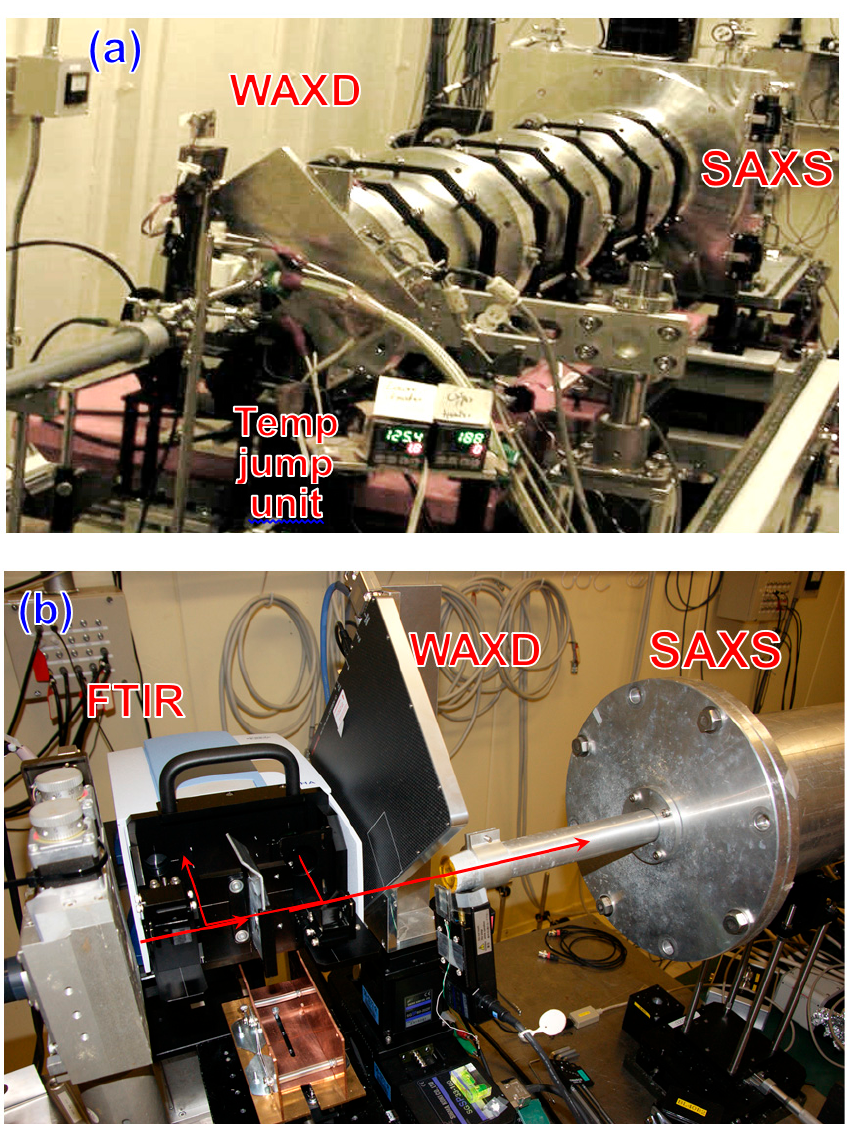
Figure 1. Simultaneous measurement systems in the synchrotron facilities. ( a ) WAXD and SAXS; ( b ) WAXD, SAXS, and FTIR spectra. In these two cases, the detectors were a flat panel (WAXD) and an image-intensifier-CCD (SAXS).